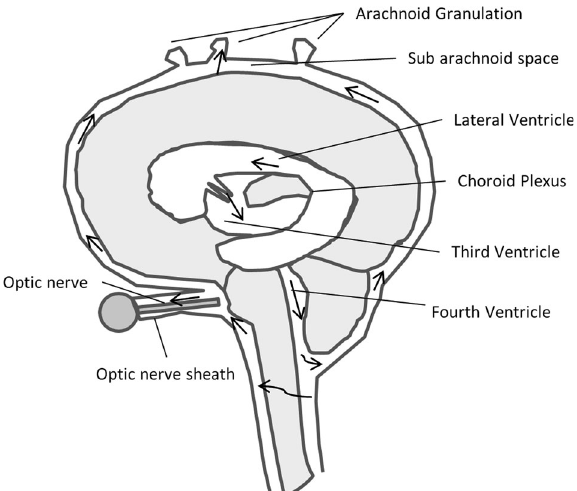
Fig. 1 The current understanding of cerebrospinal fl uid (CSF) dynamics is that the fl uid is produced in choroid plexuses and moves from the third to the forth ventricle. The CSF then moves into the subarachnoid space, continuous along the optic nerve (ON) to the back of the eye. The Illustration is based on the original from the Intracranial Hypertension Research Foundation (www.